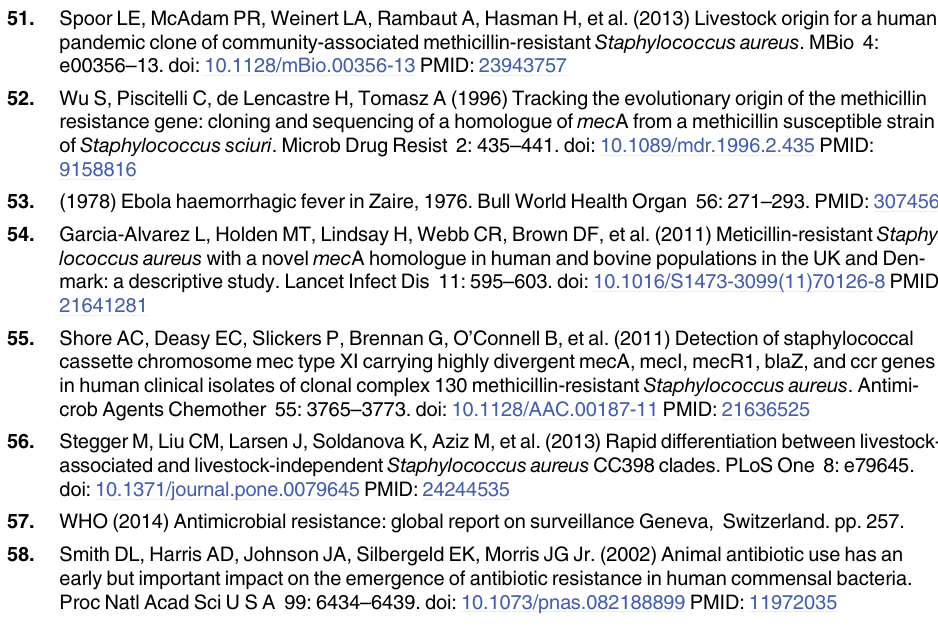
PLOS Pathogens | DOI:10.1371/journal.ppat.1004564 February 5,